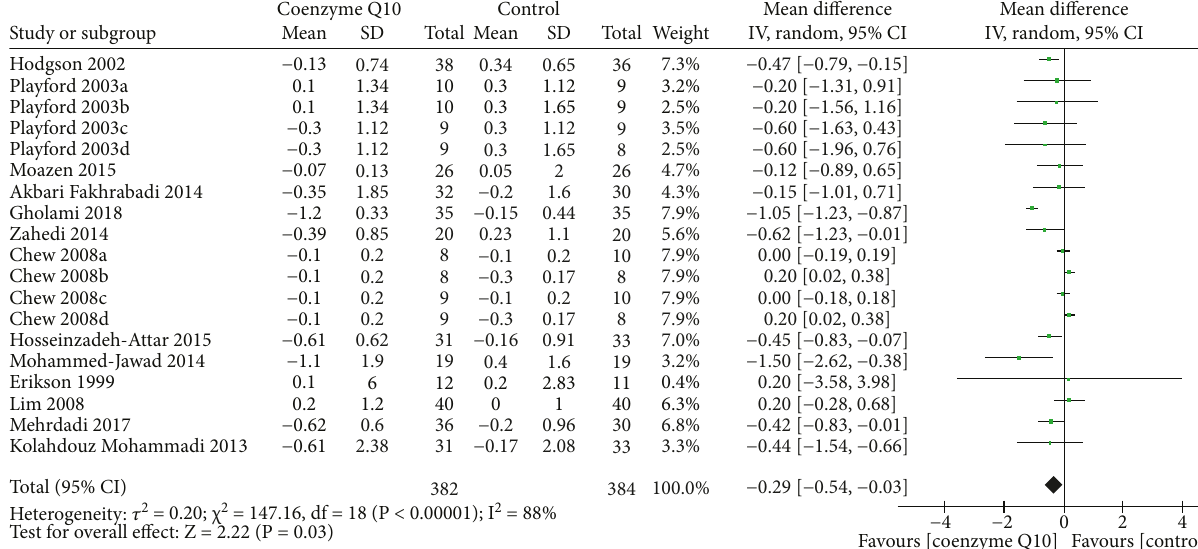
Figure 3: Glycosylated